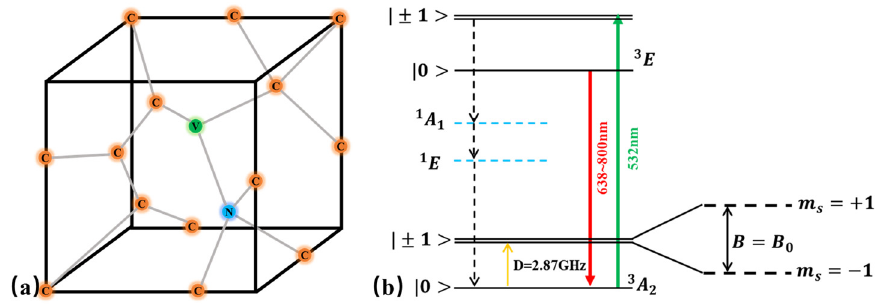
Figure 1. NV color center in diamond structure. ( a ) Schematic diagram of NV color center in diamond structure. ( b ) Energy level diagram of NV color center in diamond.